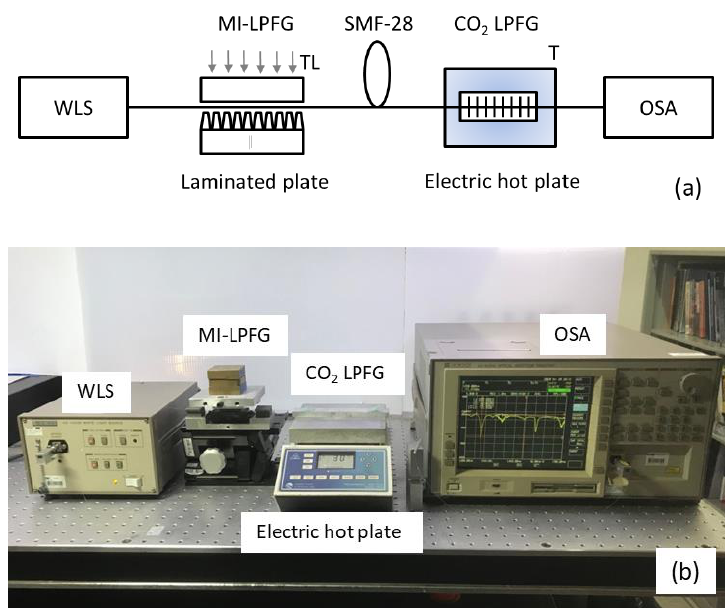
Figure 1. Experimental configuration: ( a ) schematic and ( b ) photography.